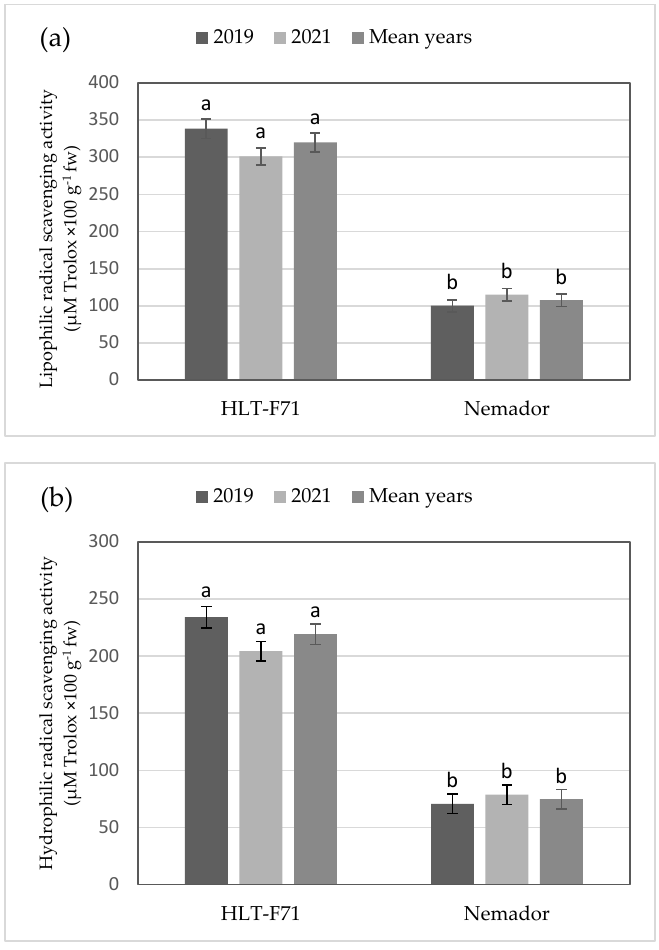
Figure 1. ( a ) Lipophilic, ( b ) hydrophilic and ( c ) total radical scavenging activity of the tomato vari ‐ eties grown organically during the two growing seasons. Error bars represent ±S.E. ( n = 4). a,b Within each year, means with different letters are significantly different at p < 0 . 05 by LSD test. 4.